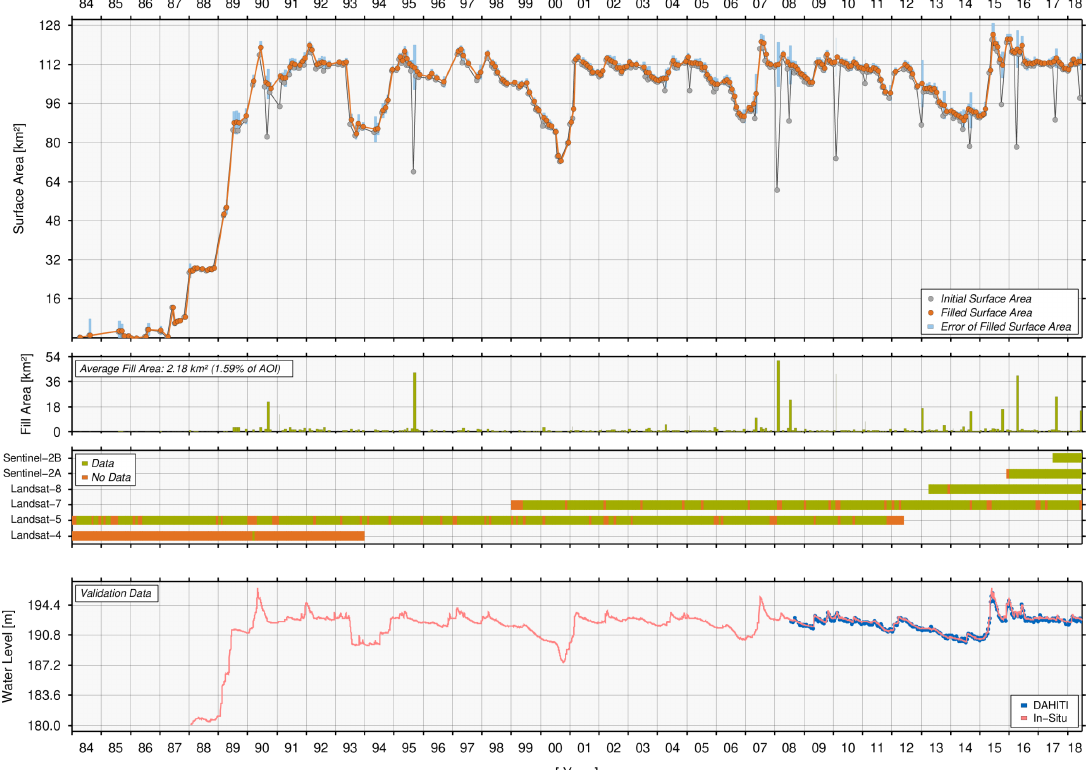
Figure 13. Water surface area time series (orange) and its errors (blue) of Lake Ray Roberts. Additionally, the initial surface area with data gaps (gray) and the filled area (green) are shown. Also, the data availability of monthly optical images from Landsat and Sentinel-2 is presented. Finally, the water level time series from in situ stations and DAHITI which are used for validation are